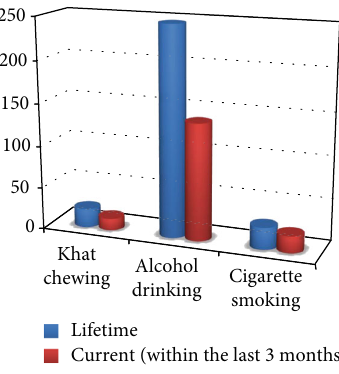
Figure 2: Distribution of substance-related factors among high school students at Aksum town, 2019 ( n = 624